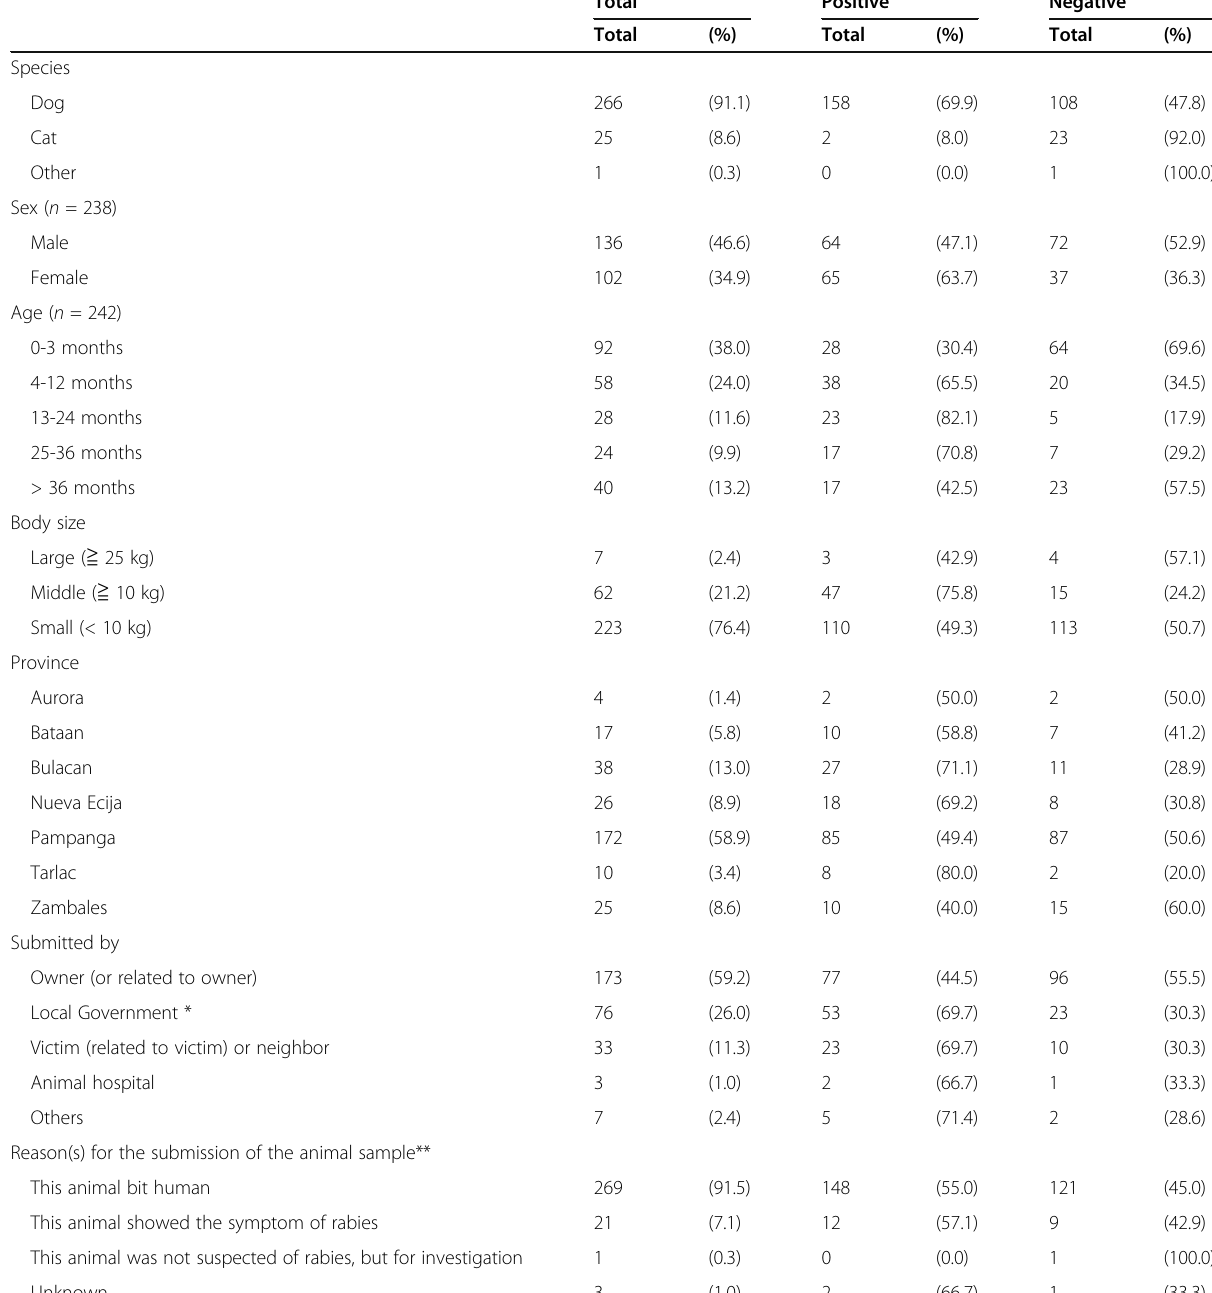
Table 1 Characteristics of 292 submitted animal